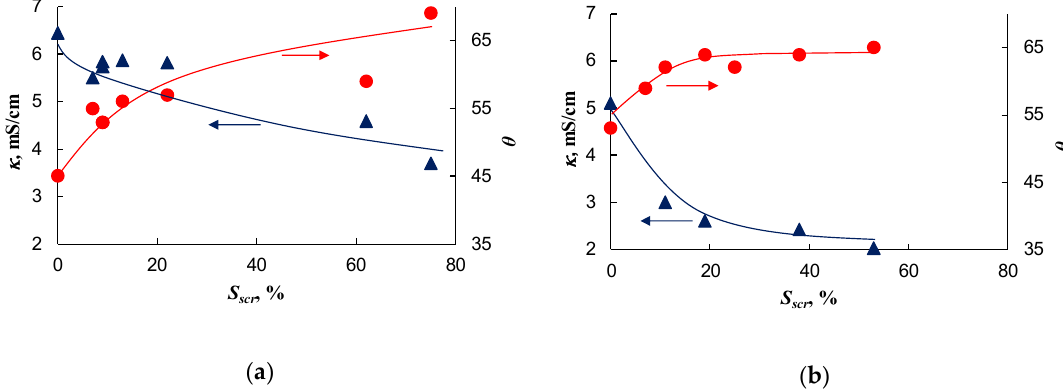
Figure 7. Dependence of the membrane conductivity, κ , measured in a 0.5 M NaCl, and the contact angle, θ , on the fraction of the screened surface, S scr . The results of measurements of two series of the modified membranes based on the AMX-Sb ( a ) and AMX ( b ) membranes. The lines are drawn to guide the eye.